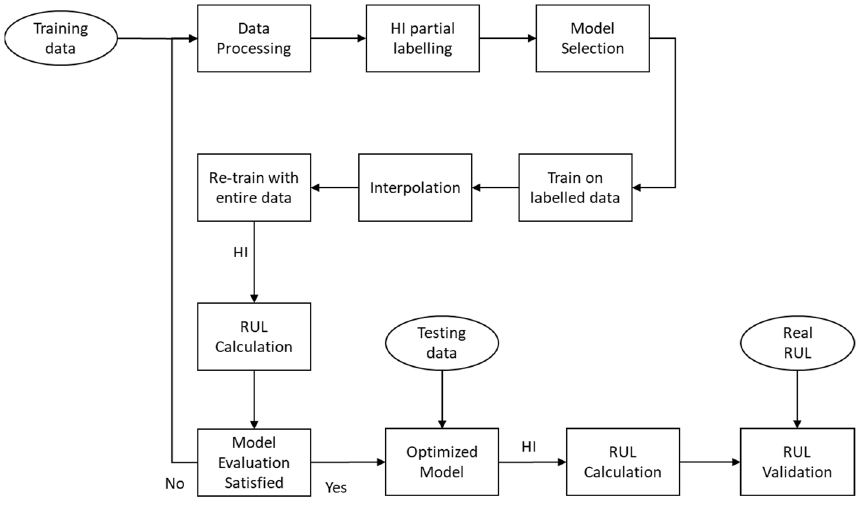
Figure 7. The HI prediction and RUL estimation for FD001_test turbo engine unit 84. Figure 8 represents the flowchart of our interpolation and machine learning-based prediction model. First, a model is trained with partially labeled data. Then, the trained model is used to interpolate the rest of the unlabeled training points with HIs. After the interpolation, the entire HI labeled dataset is used as a feedback mechanism for the model to re-train the model.